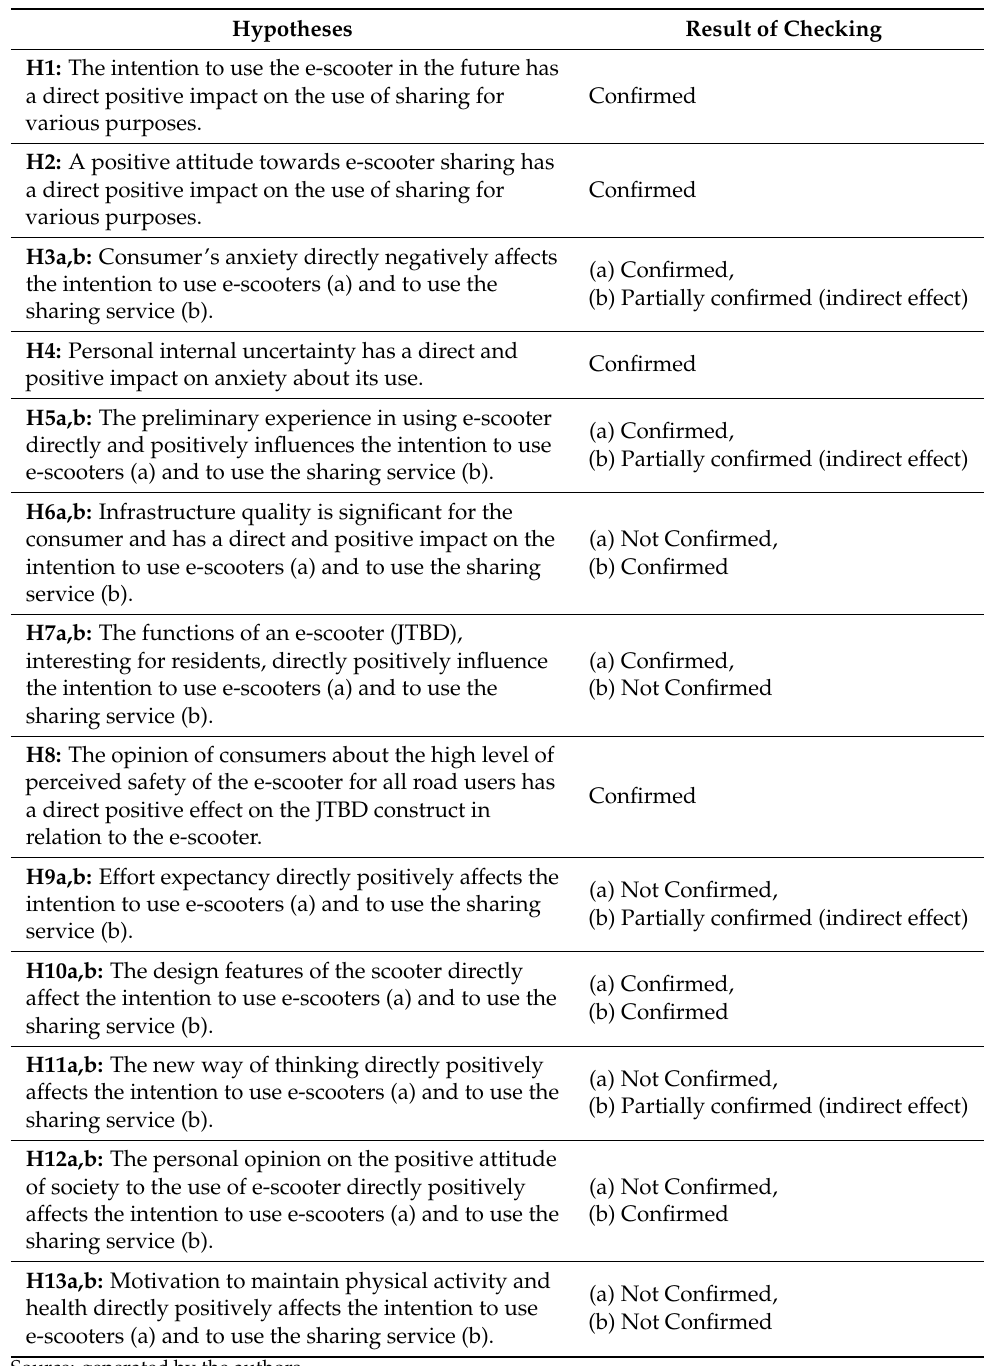
Table 4. Results of testing the